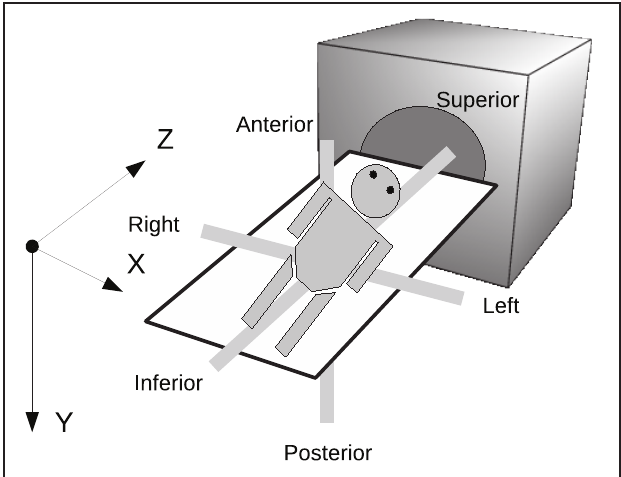
FIGURE 4 | Subject orientation. A coordinate system ( X , Y , Z ) is defined when a subject is scanned. The subject’s orientation is recorded relative to